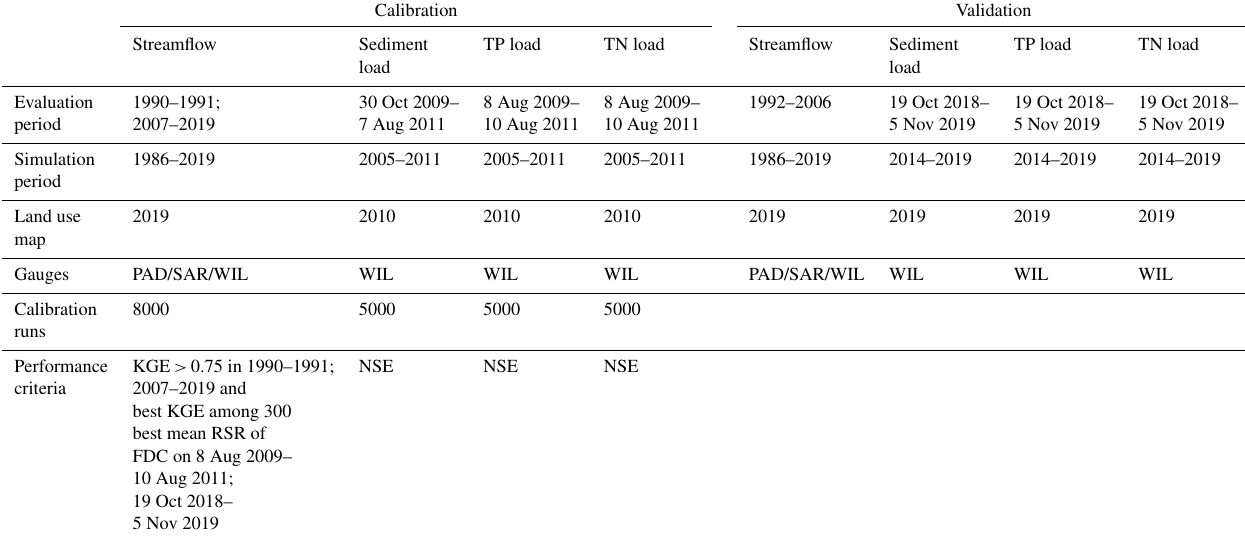
Table 2. Overview of SWAT model calibration and